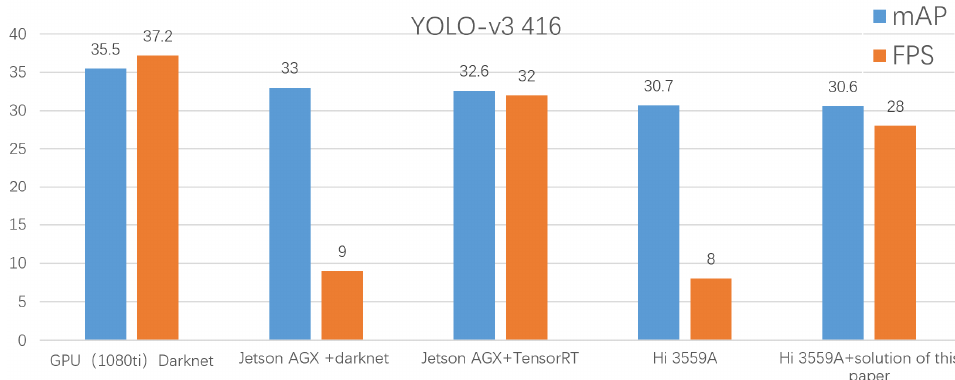
Figure 17. Comparison of network solutions.